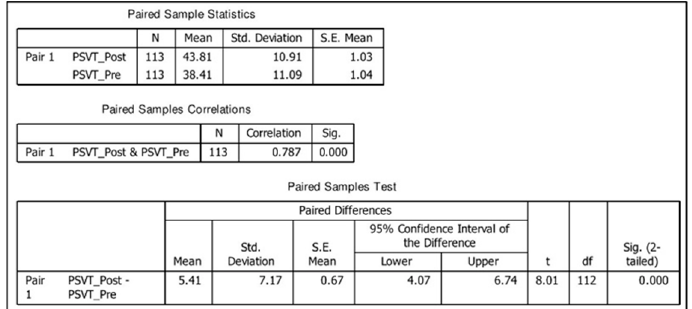
Figure 15. Paired t-test for the Computer Graphics group.